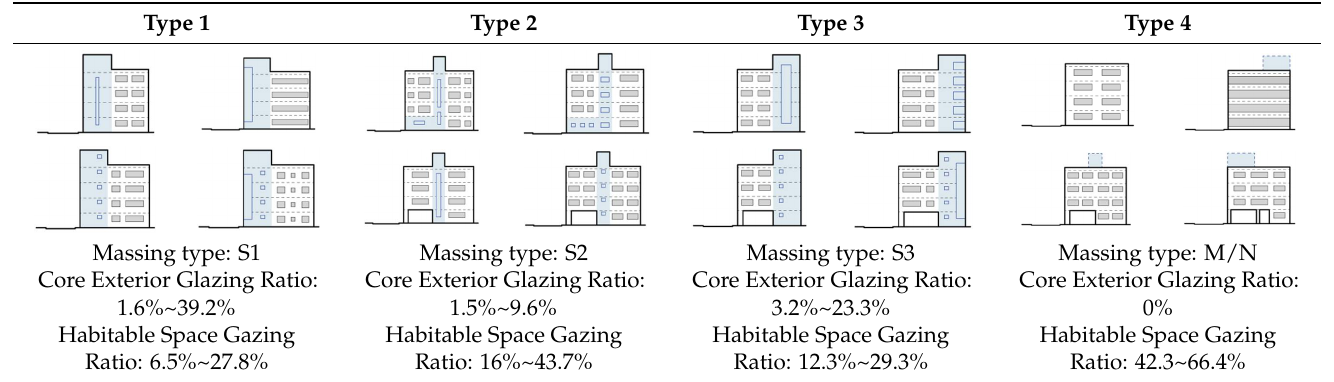
Table 3. Analysis of potential daylight access on south elevations.